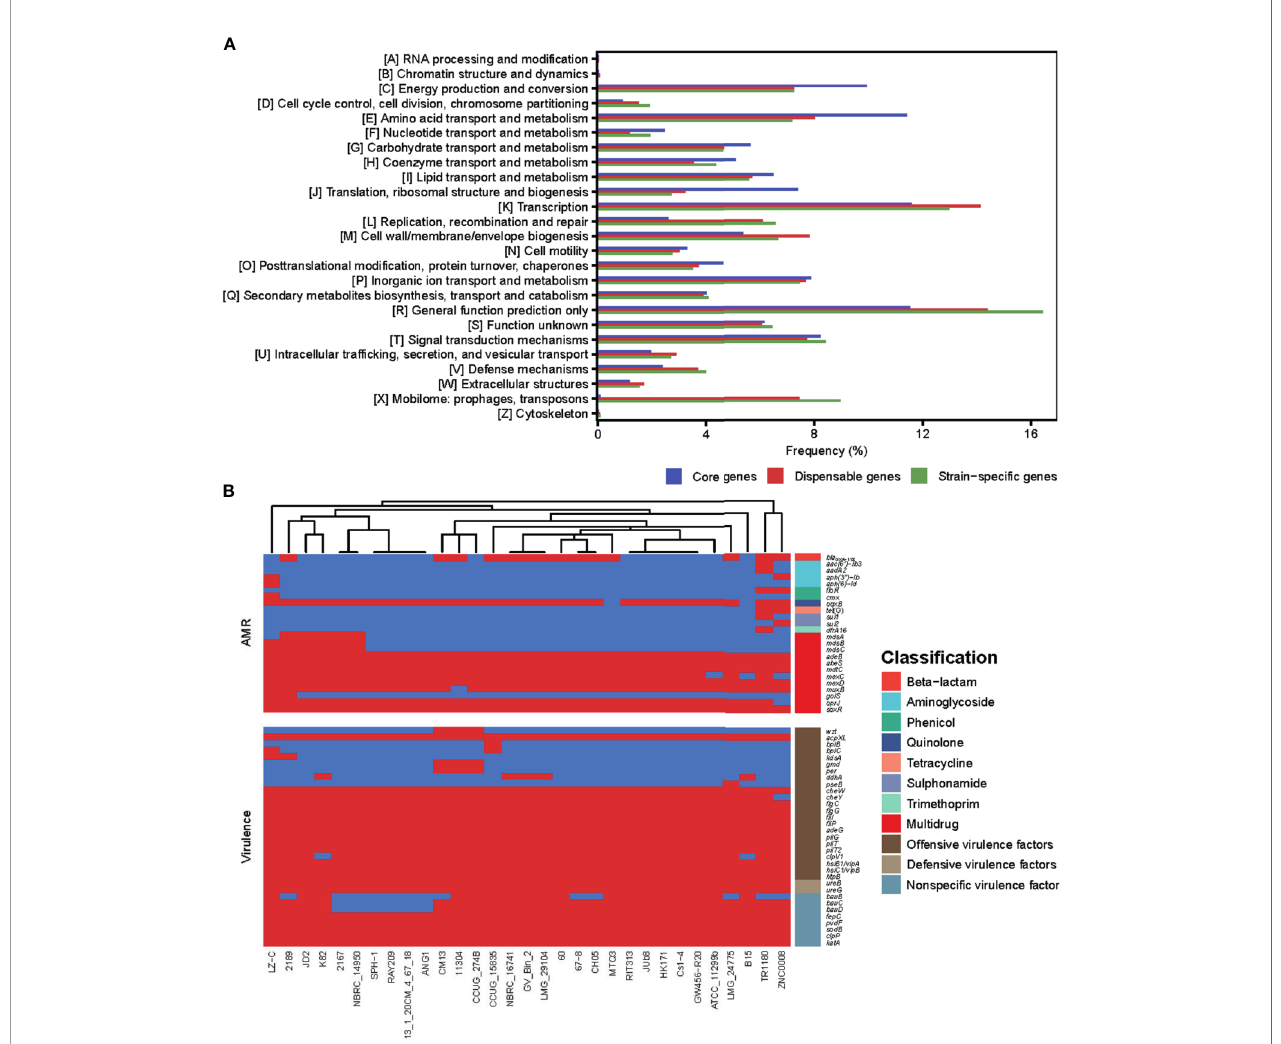
FIGURE 3 | (A) The COG function classi fi cation comparison of core genes, dispensable genes and unique genes in the genus Delftia . (B) The resistome and virulome of 31 Delftia